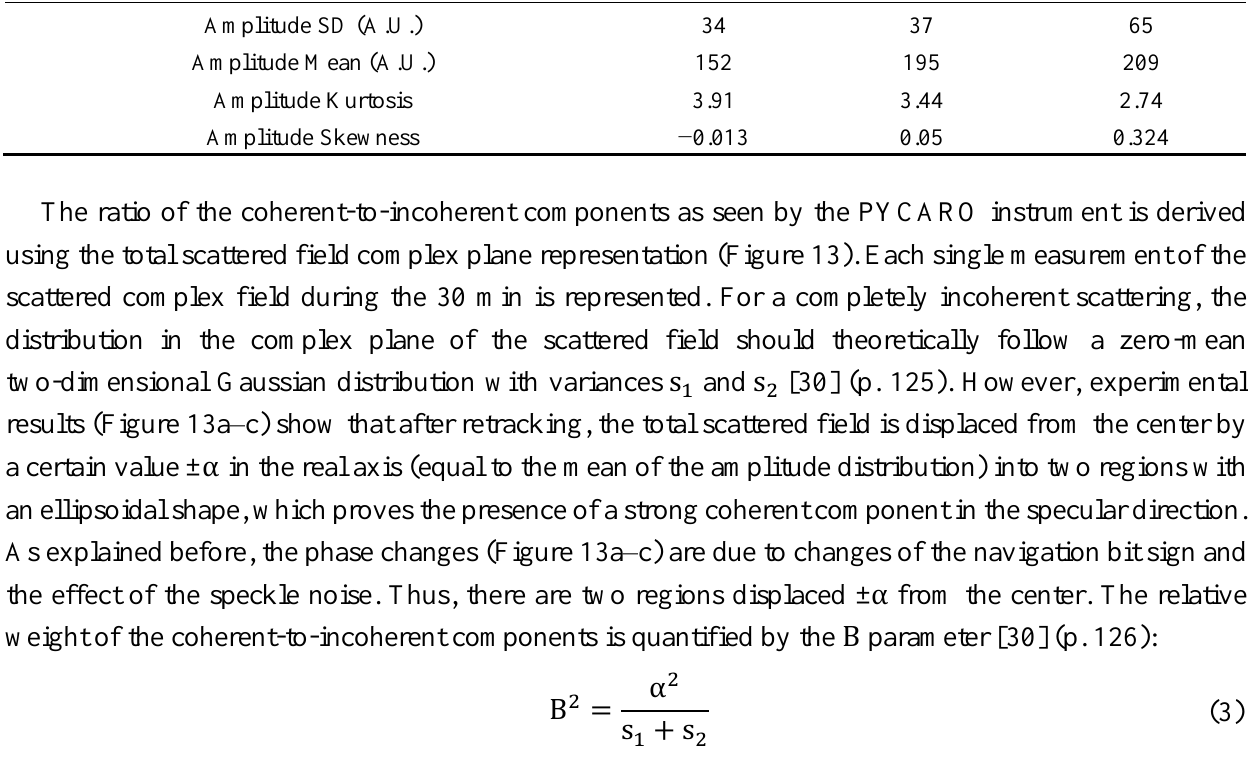
Table 3. Statistical analysis of the amplitude (after retracking) distribution of the scattered GPS signals over the CIEM wave channel at different elevation angles: θ